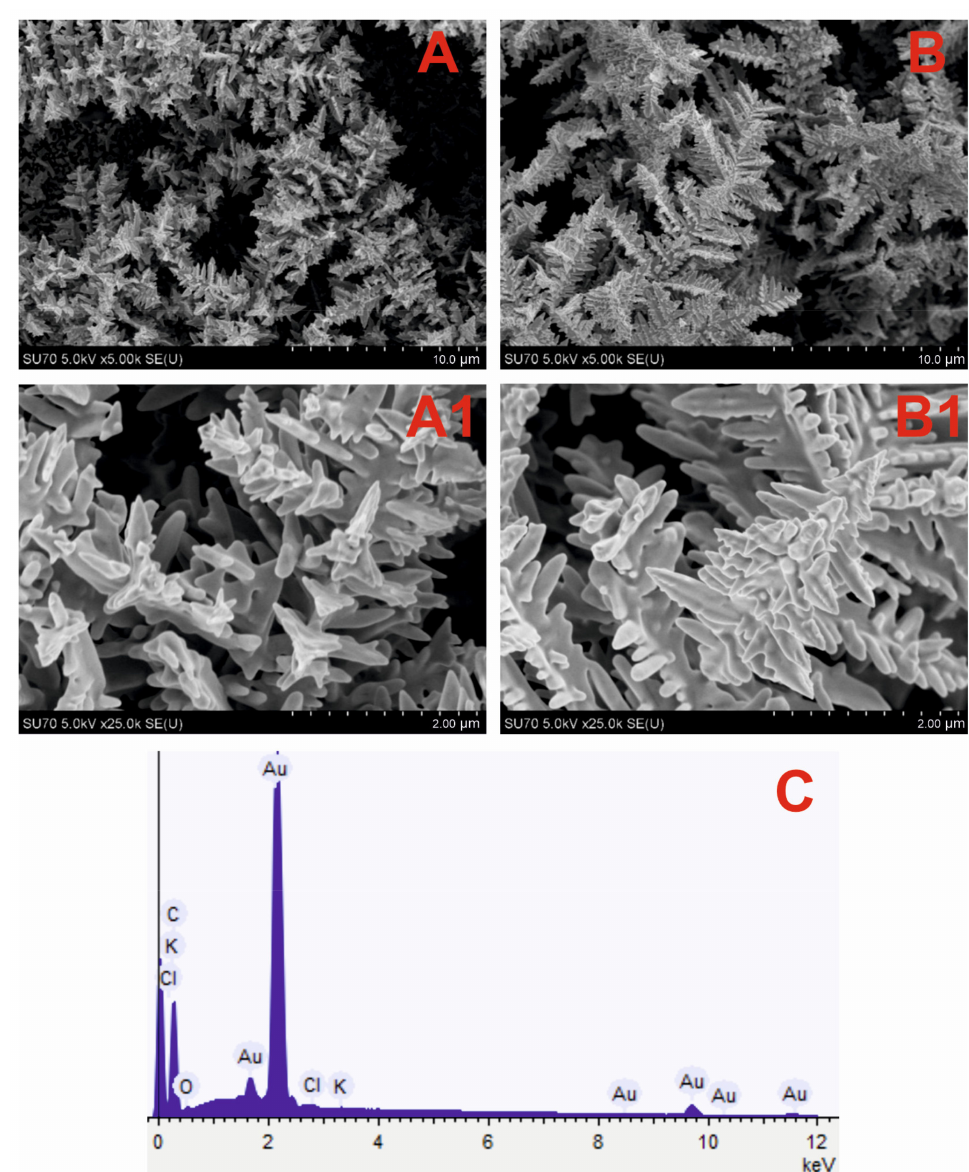
Figure 1. SEM images of the DGNs electrochemically deposited on a GR electrode at a constant − 0.2 V potential for 200 s ( A , A1 ) and 400 s ( B , B1 ) from a 10 mM solution of HAuCl 0.1 M KNO 3 (pictures ( A1 , B1 ) are magnified images of ( A , B )) and EDS spectrum ( C ) of dendritic gold nanostructures presented in ( A ) SEM